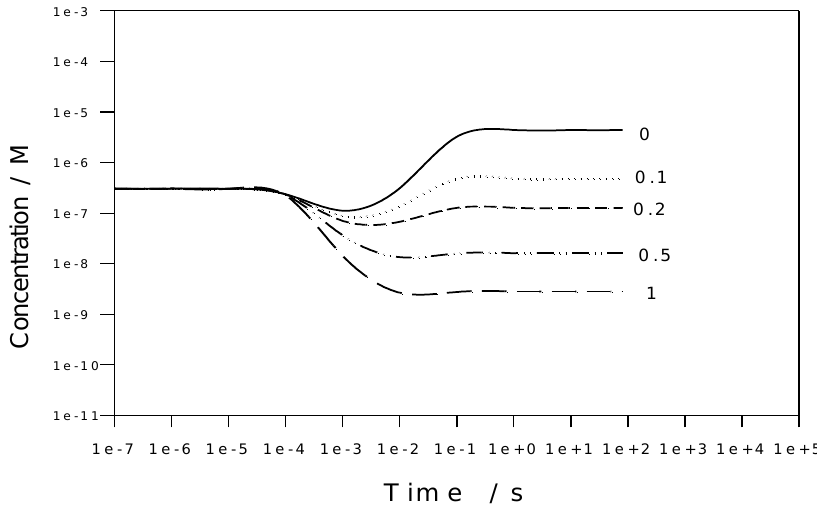
Figure 32. Predicted concentration of oxygen in the single modeled module as a function of time for different initial concentrations of hydrogen in cc (STP)/kg H 2 O.